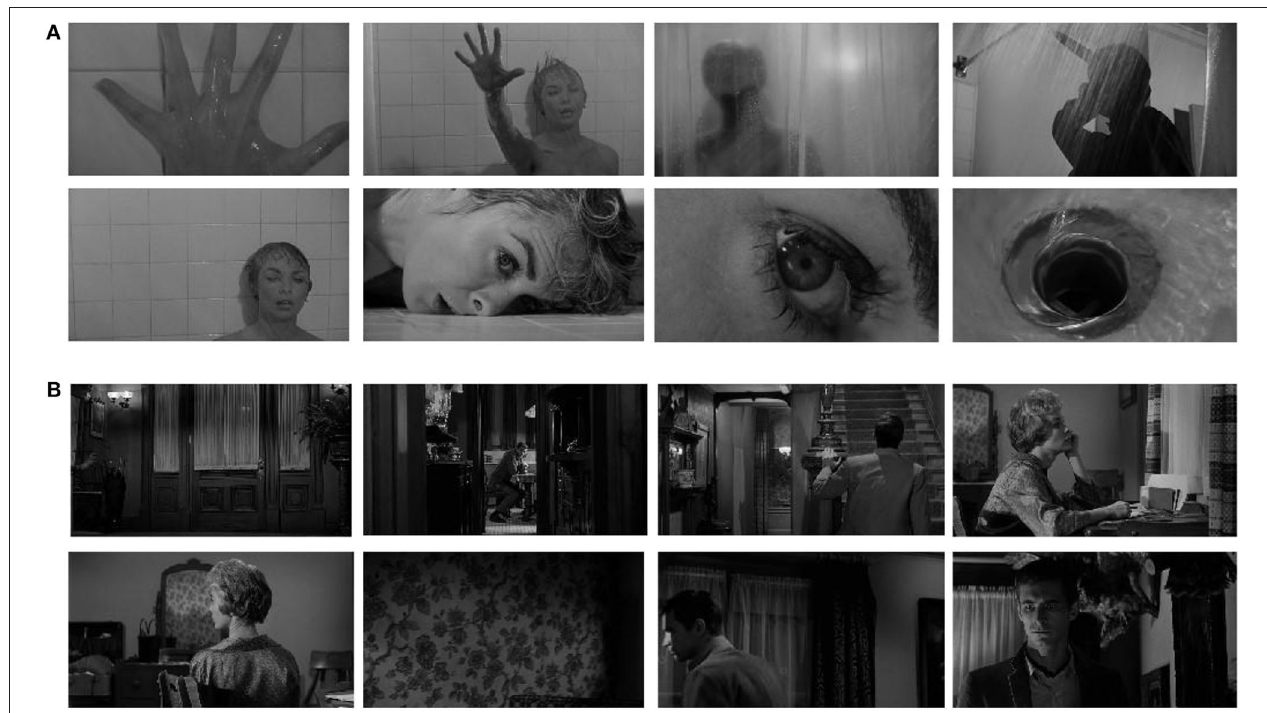
FIGURE 12 | (A) Images with high emotional rating scores. (B) Images with low emotional rating scores. Statistical significance tests have been performed on the high-value and low-value data, and p <